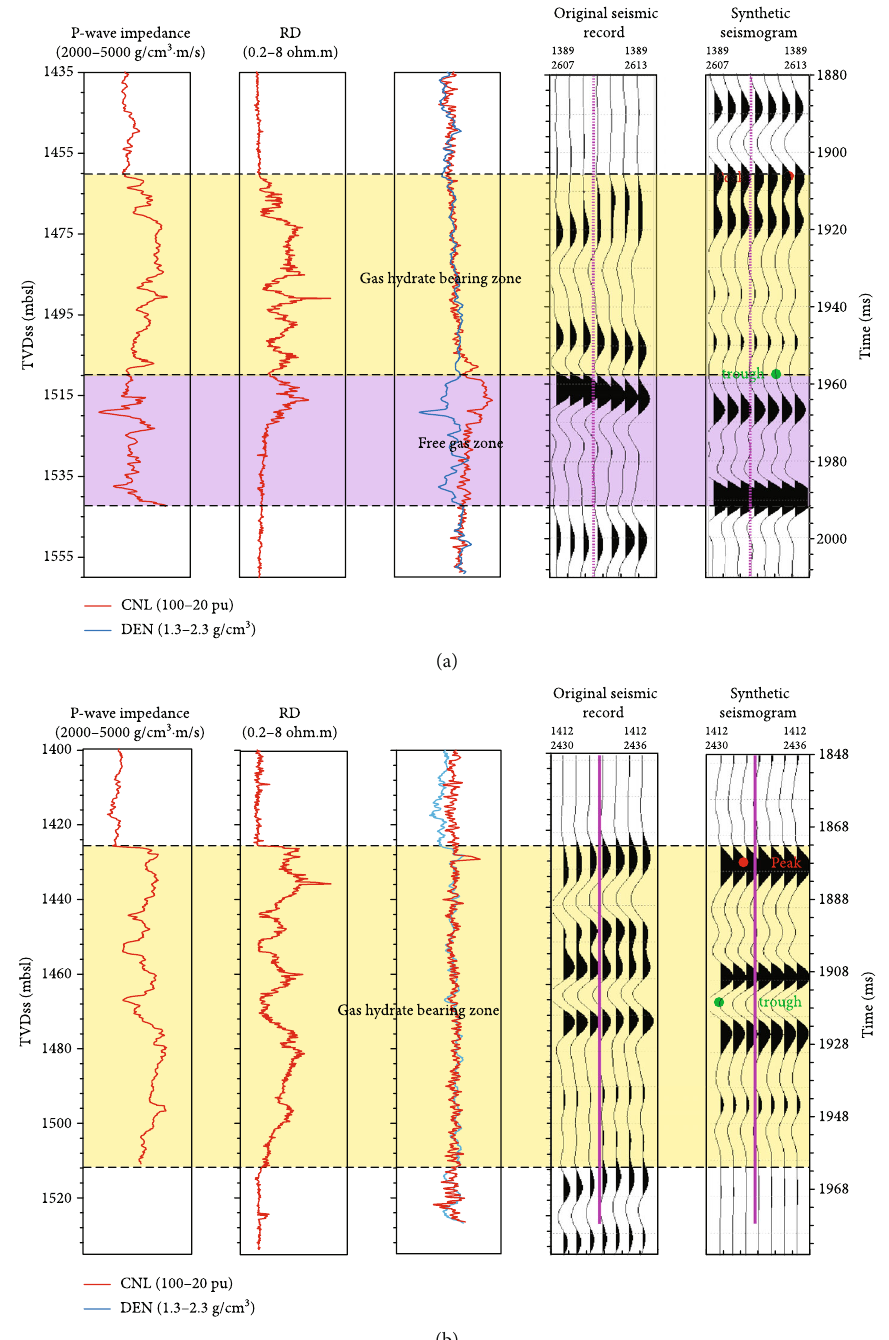
Figure 6: Logging curves and synthetic seismic records of the A-well and